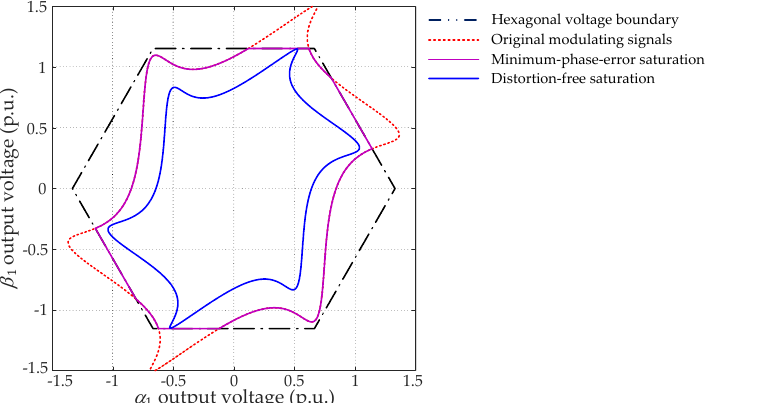
Figure 33. Comparison for n = 3 between the α 1 - β 1 output-voltage trajectories provided by conven- tional minimum-phase-error saturation (solid magenta) and by the multifrequency distortion-free method (solid blue) from [137,545,557,572] (see Figure 32), for original voltage references (dashed red) containing fifth- and seventh-order harmonics, as well as positive- and negative-sequence fundamental. Min–max zero-sequence injection based on (2) is considered in all cases.